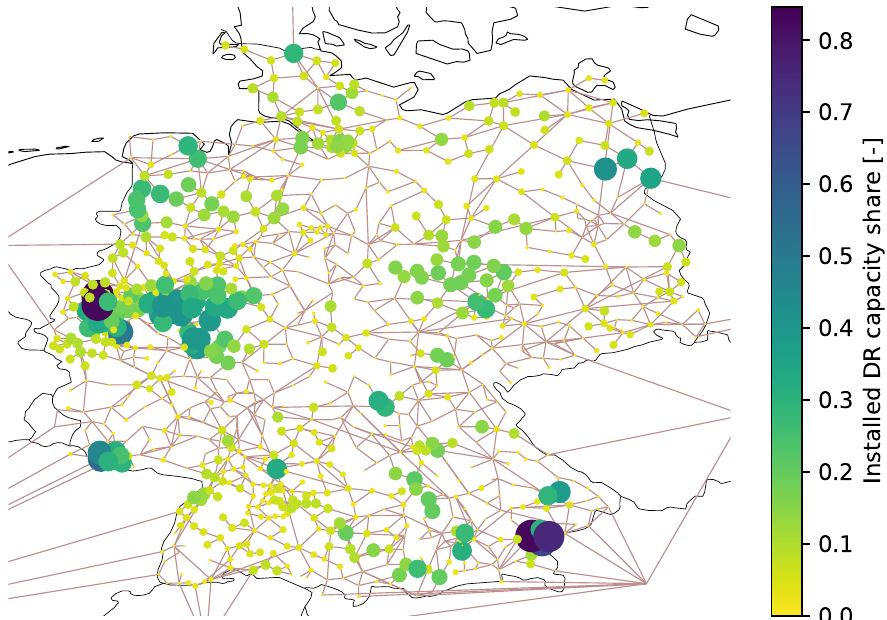
Figure 10. Spatial distribution of the share of the installed DR capacity in the total DR potential per grid